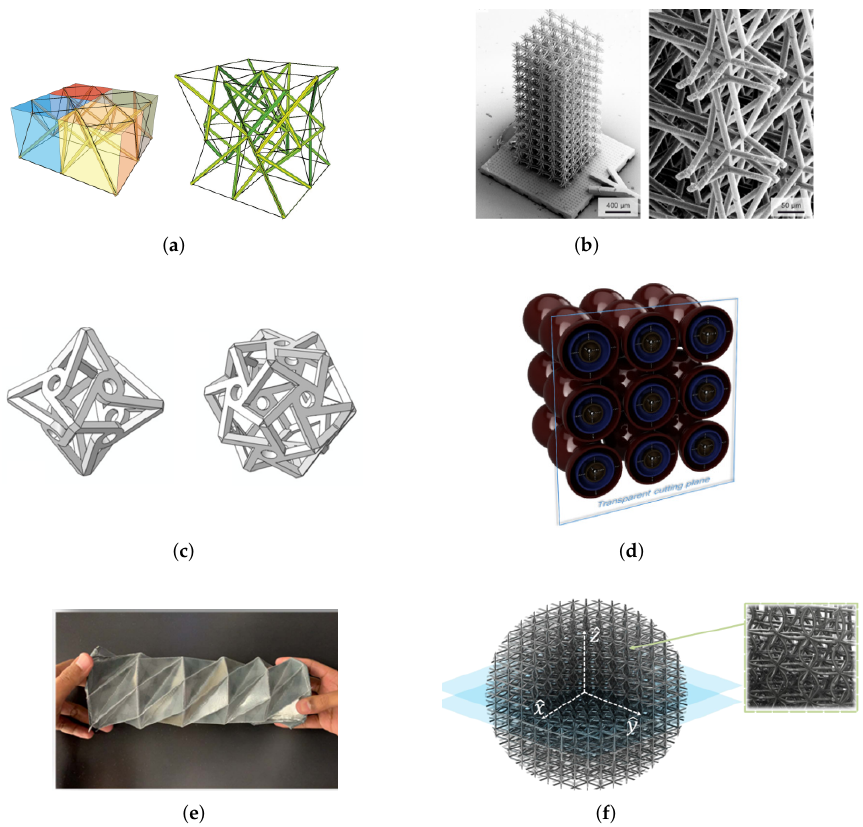
Figure 2. Examples of 3-D metamaterials. ( a – c ) Mechanical metamaterials [10–12]. ( d ) Acoustic metamaterial [13]. ( e ) Antenna [14]. ( f ) Electromagnetic metamaterial